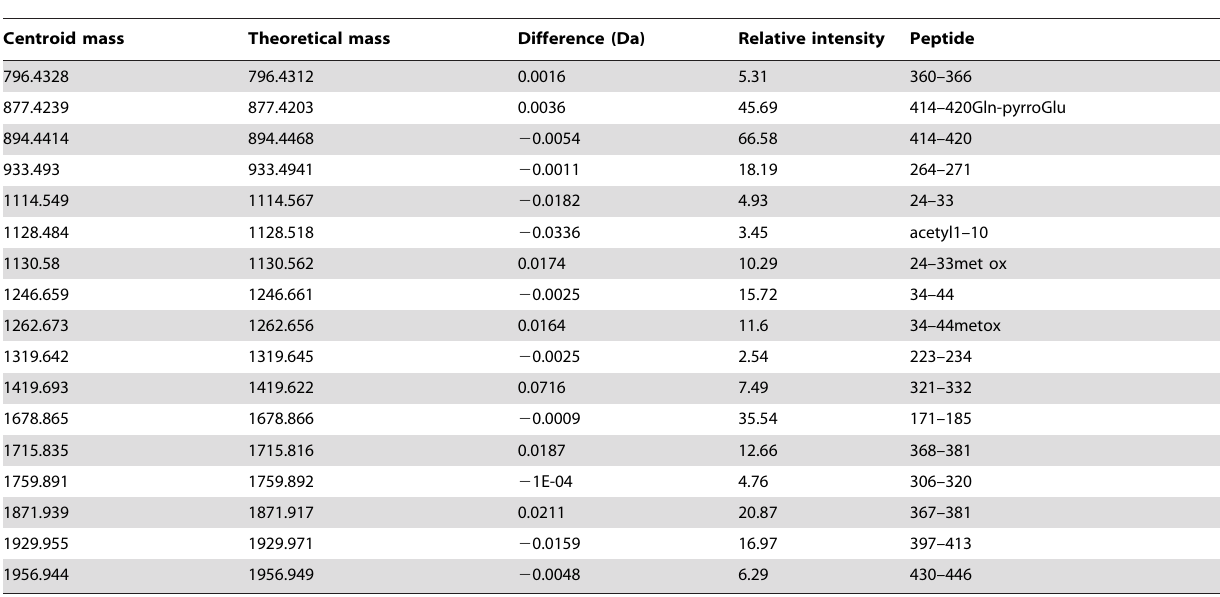
Table 1. MALDI-TOF Lamprey RPE65 peptide mass fingerprinting.